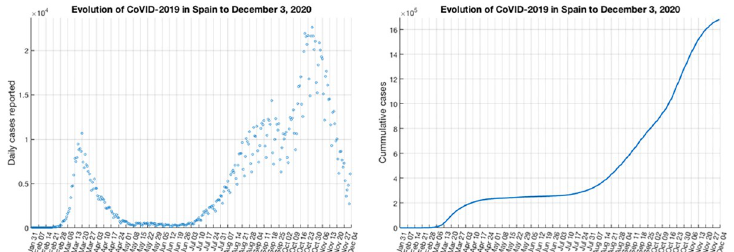
Fig 1. Cases reported in Spain from January 31, 2020, to December 3, 2020. a. Profile of daily cases reported. b. Curve of cumulative number of